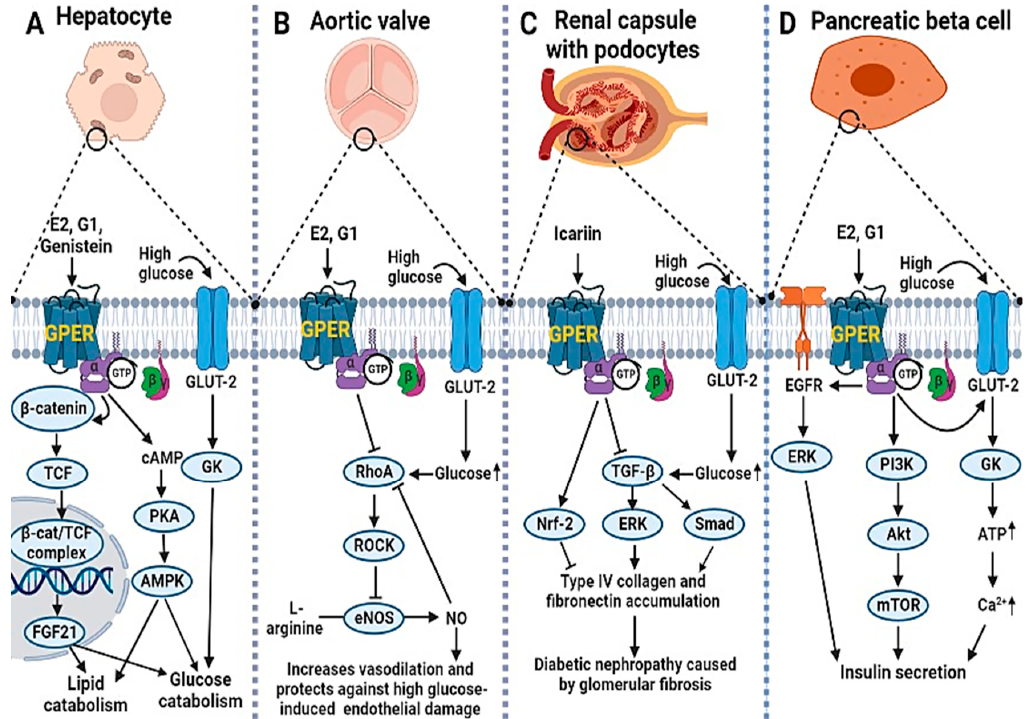
Figure 1. A comprehensive overview of the physiological and pathological changes associated with high glucose-induced alterations in GPER signaling pathways and the protective roles of GPER agonists. ( A ) Genistein enhances glucose and lipid catabolism in high glucose-treated human hepatocytes by activating a GPER-mediated cAMP/PKA/AMPK signaling under physiological conditions. E2 and G1 exhibit a similar effect via GPER-mediated β -catenin/TCF/FGF21 signaling. ( B ) E2 and G1 inhibit high glucose-induced vasoconstriction and endothelial damage in human aortic cell lines and diabetic mice via a GPER-mediated RhoA/ROCK/eNOS signaling. ( C ) Icariin prevents high glucose-induced glomerular fibrosis and diabetic nephropathy in renal tissues of diabetic mice via a GPER-mediated inhibition of TGF- β and activation of Nrf-2 signaling pathways. ( D ) E2 and G1 augment high glucose-stimulated insulin secretion in pancreatic β -cells via a GPER- mediated upregulation of GLUT-2 as well as activation of PI3K/Akt/mTOR and EGFR/ERK signaling pathways under physiological conditions. AMPK = adenosine 5 (cid:48) - monophosphate-activated protein kinase, ATP = adenosine triphosphate, Akt = Ak strain transforming protein/protein kinase B, β - cat = β -catenin, cAMP = cyclic adenosine monophosphate, E2 = 17 β -estradiol, EGFR = epidermal growth factor receptor, eNOS = endothelial nitric oxide synthase, ERK = extracellular signal-regulated protein kinase, FGF21 = fibroblast growth factor 21, G1 = a synthetic and selective GPER agonist, GK = glucokinase, GLUT-2 = glucose transporter 2, GPER = G-protein-coupled estrogen receptor, mTOR = mammalian target of rapamycin, NO = nitric oxide, Nrf-2 = nuclear factor erythroid 2- related factor 2, PKA = protein kinase A, PI3K = phosphatidyl inositol 3-kinase, RhoA = ras homolog family member A, ROCK = Rho-associated protein kinase, Smad = suppressor of mother against decapentaplegic. (Source: image was created in BioRender (biorender.com), accessed 25 June